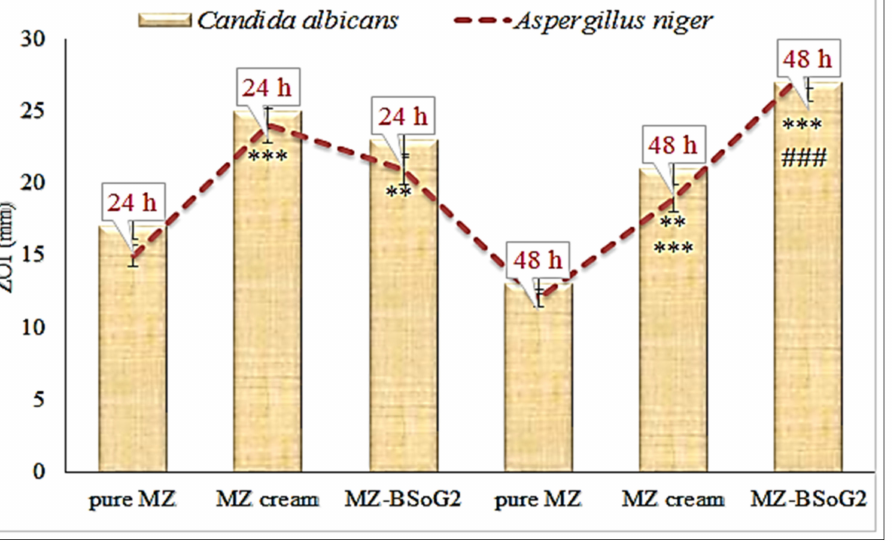
Figure 6. Comparative antifungal activities of pure miconazole (MZ), miconazole marketed cream (MZ cream), and optimized miconazole bilosome gel (MZBSoG2) against C. albicans and A. niger . Study completed in triplicate, and zones of inhibition (ZOIs) shown as mean ± SD. Statistical study compared with pure MZ. Highly significant compared to pure MZ *** ( p < 0.001); significant compared to pure MZ ** ( p < 0.01); Highly significant to pure MZ at 48 h ### (( p <